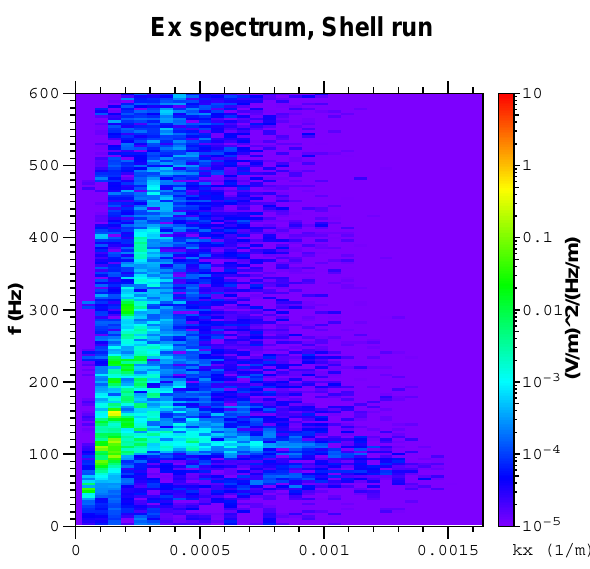
Fig. 9. Same as Fig. 8 but for the shell distribution run.